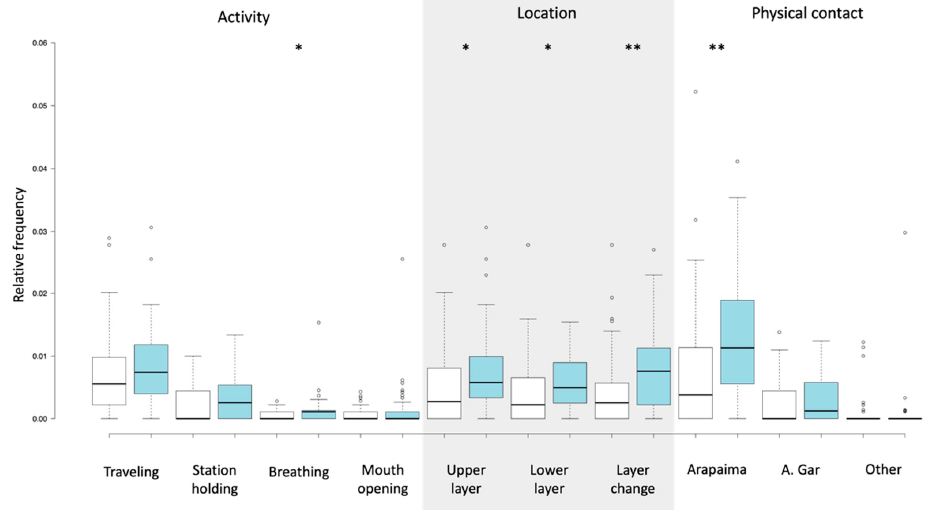
Figure 4. The relative frequency (observed frequency/fish presence in the exhibit tank) of the ten monitored behaviours during test (blue) and baseline (white) conditions. Boxplots represent the median and interquartile range (IQR) with whiskers indicating the top and bottom 5% of occurrences and outliers are represented by the circles. Significant change between baseline and test conditions is marked with asterisks (* p > 0.05, ** p > 0.01).